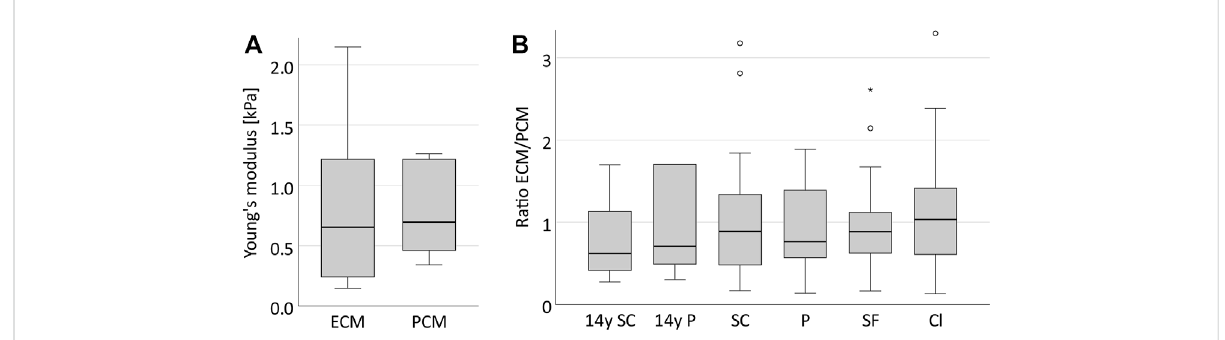
FIGURE 6 The ECM and PCM in the human IVD present with a similar stiffness and their ratio remains constant across all spatial chondrocyte patterns. Boxplots illustrating the stiffness of the ECM and PCM in one supposedly healthy anulus fi brosus sample from a 14-year-old patient (A) and its